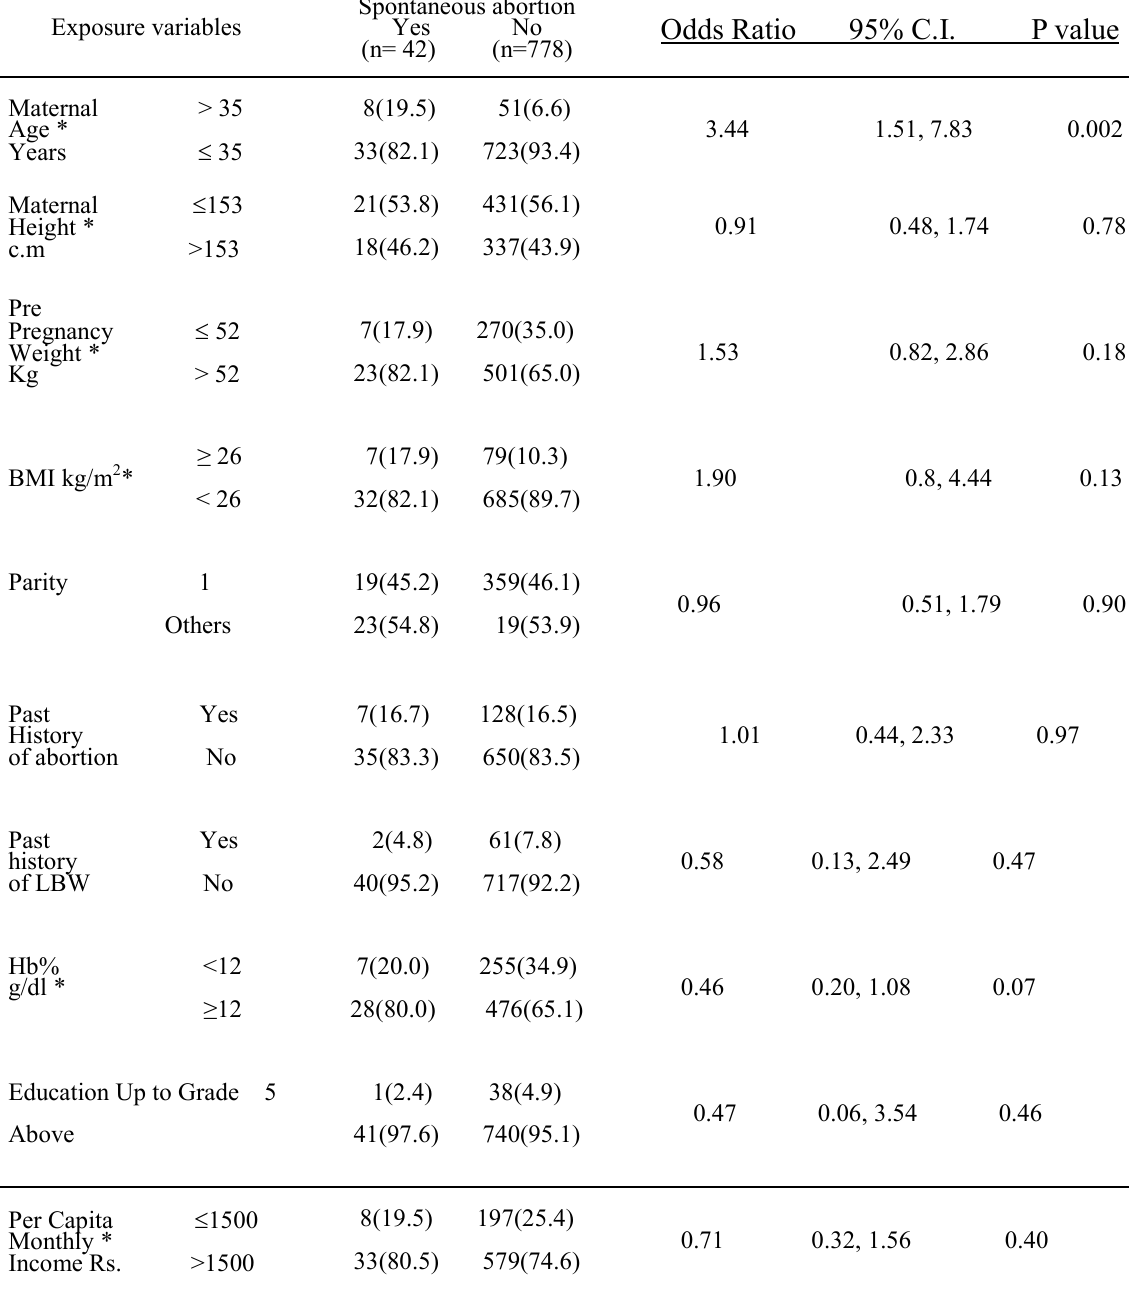
Table 1 – Unadjusted Odds ratios for spontaneous abortion by selected socio-demographic and maternal variables Exposure